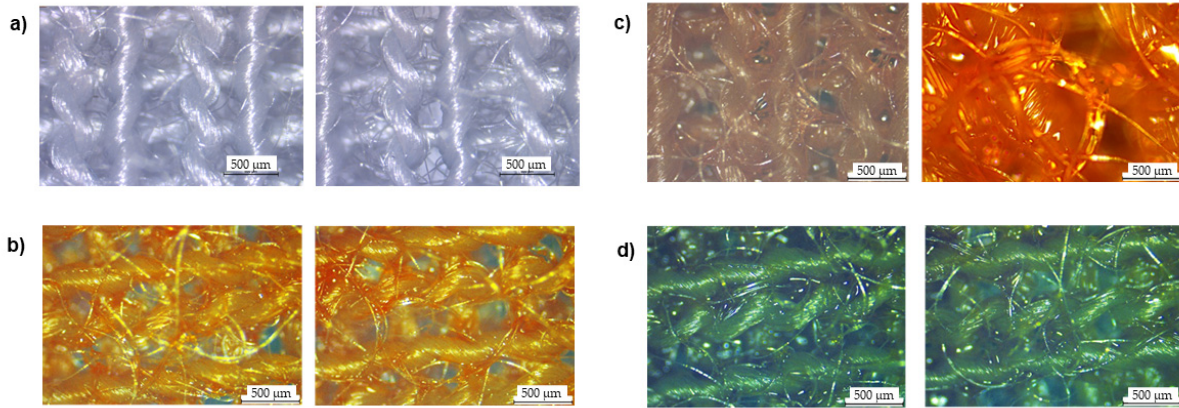
Figure 3. Cotton fibers were observed under a microscope at a total magnification of 50, ( a ) before and after coating with ( b ) methyl red and bromothymol blue (MR:BB), ( c ) methyl red and methyl red sodium salt (MR:MR) and ( d ) methyl orange and bromocresol purple (MO:BP).